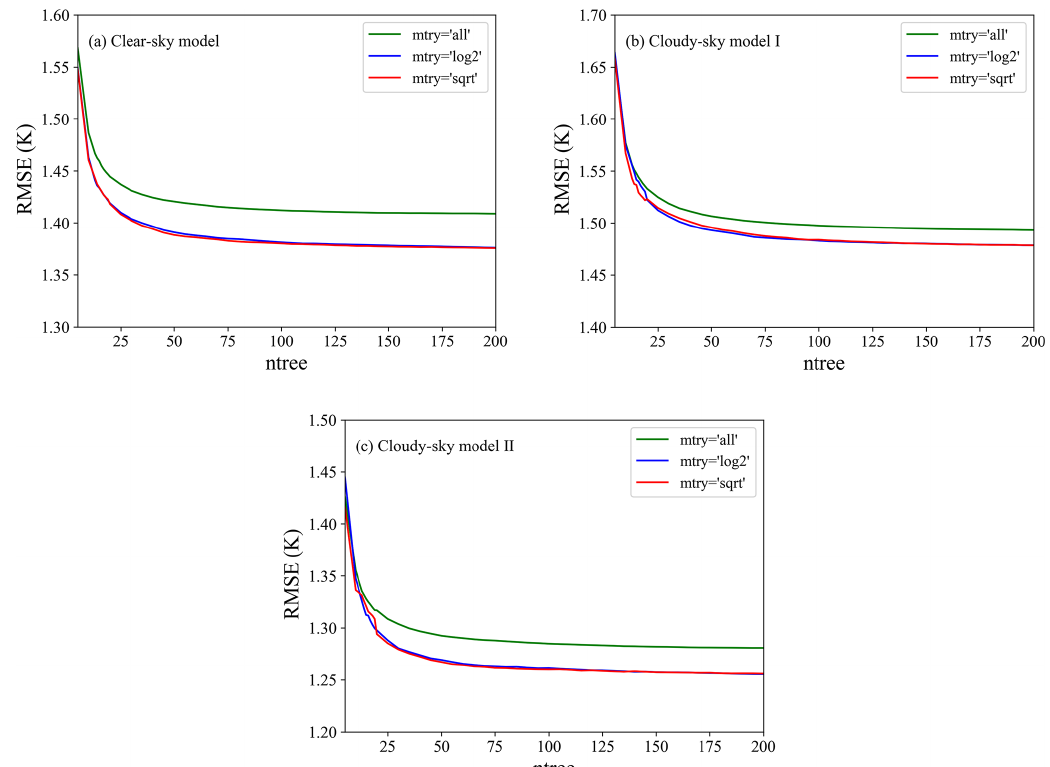
Figure 5. RF model performance sensitivity to